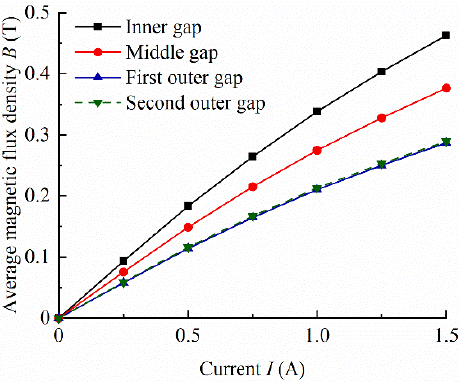
Figure 10. Average magnetic flux density with different applied current inputs.